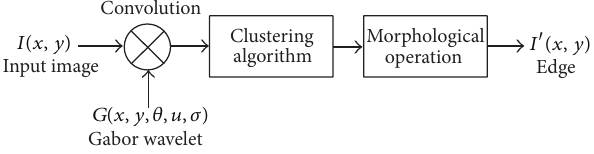
Figure 1: The proposed edge detection